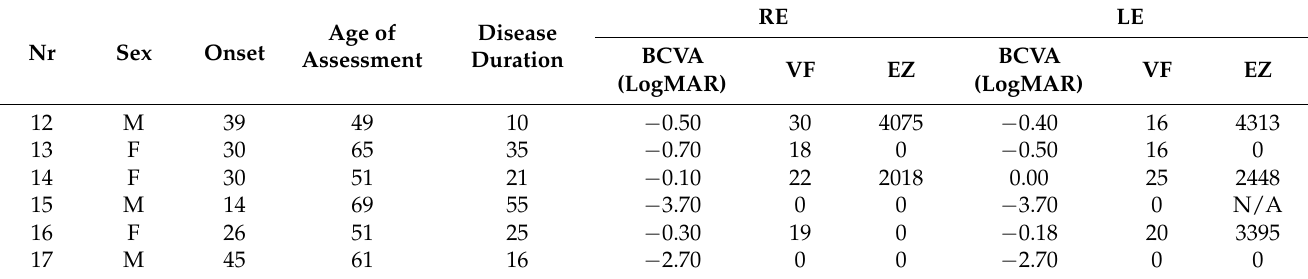
This picture is associated with changes in the sub - RPE slab (areas of increased SRI) within the 5 mm circle outlined in white. The red line shows the atrophic area closest to the fovea. The staging score was significantly correlated with age and disease duration (r = 0.54, p < 0.01) as shown in Figure 2A,B. An age of 45 years and a disease duration of 15 years corresponded to the appearance of an advanced RP score (≥8). The data showed a trend to saturate after the age of 50, indicating a ceiling effect.